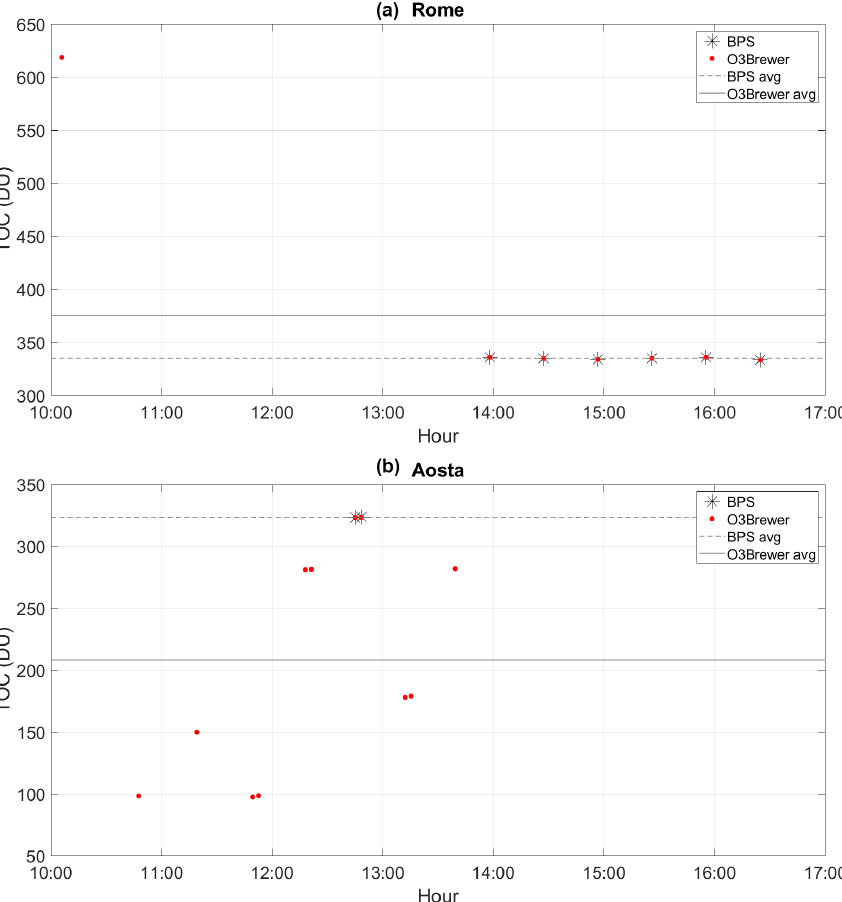
Figure 11. Individual TOC values generated by BPS and O3Brewer on 23 June 2001 at Rome (a) and on 5 January 2010 at Aosta (b) taken as examples where differences between BPS and O3Brewer averages occurred although the R 6 BPS is similar to R 6 smooth . Horizontal lines (dashed for BPS; solid for O3Brewer) represent the daily average